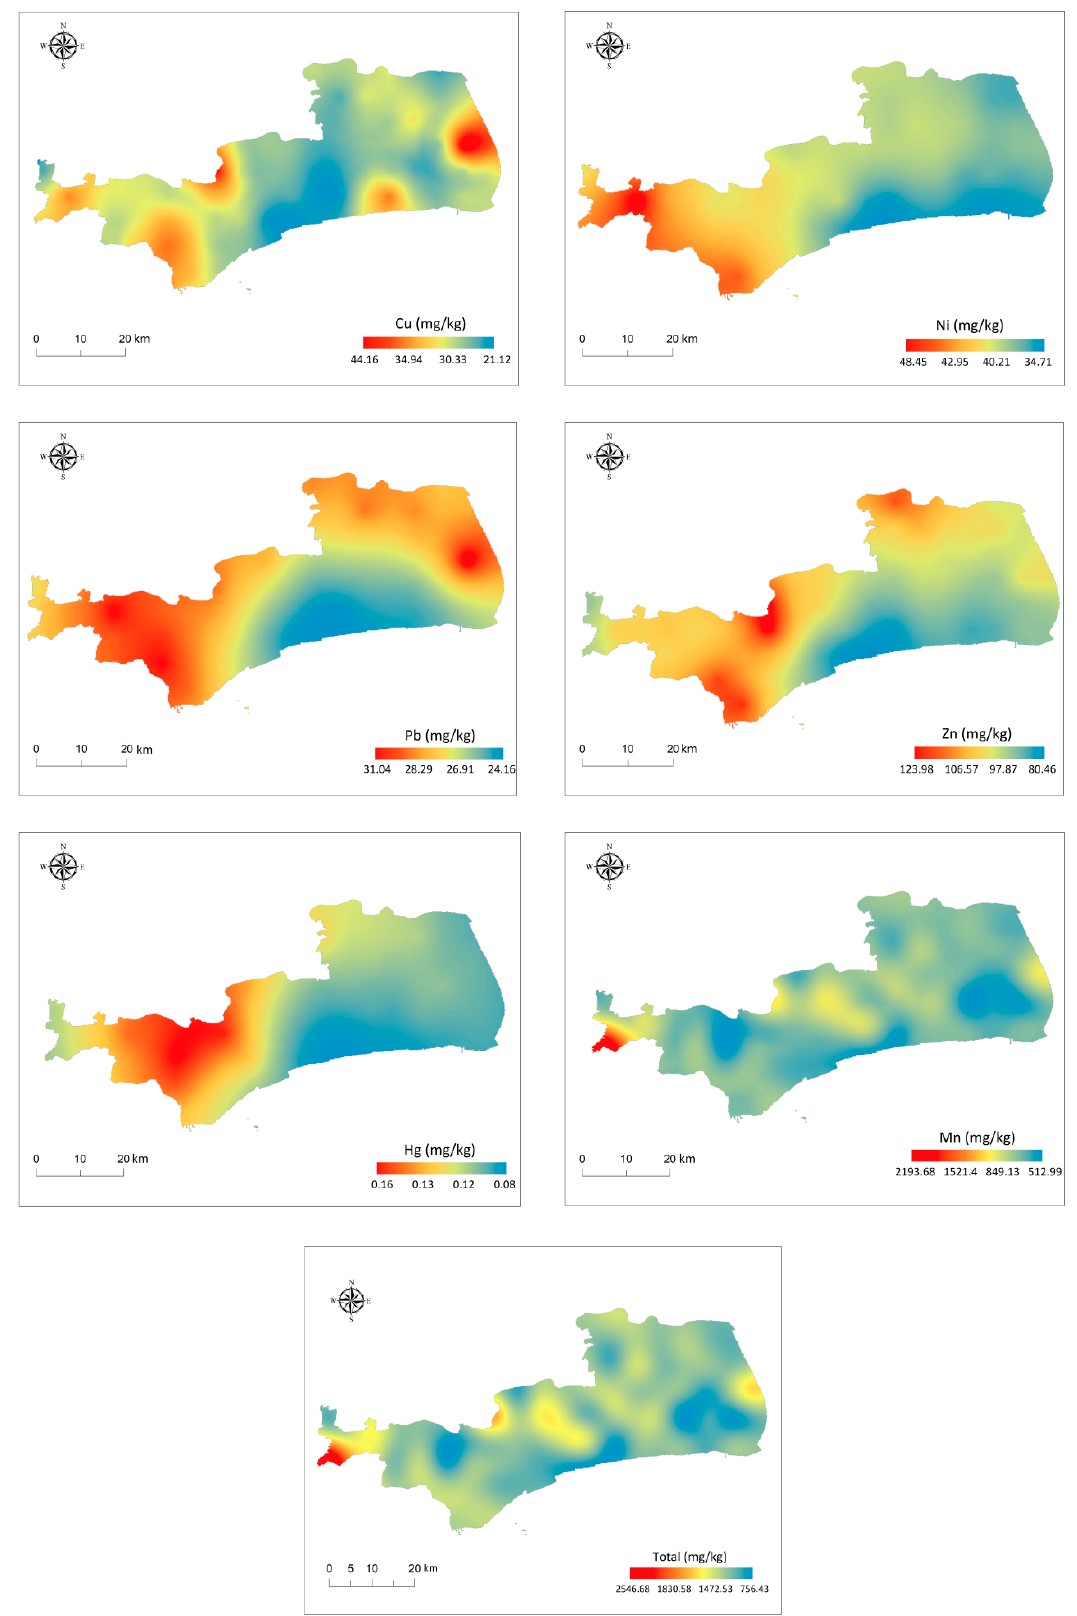
Figure 2. Spatial distribution maps of topsoil heavy metals in the study area.